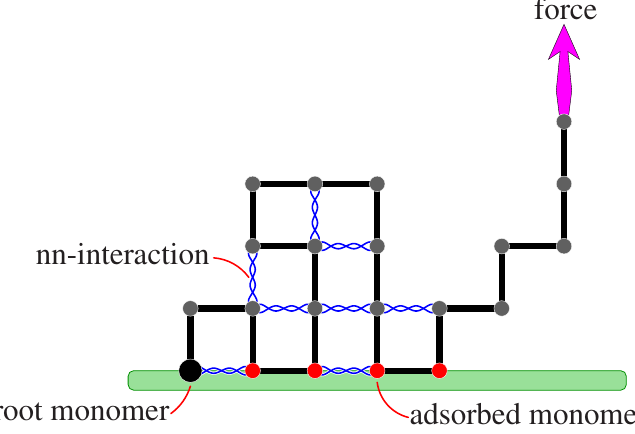
Fig. 1. A lattice model of a polymer tethered to a sticky surface under the influence of a pulling force.